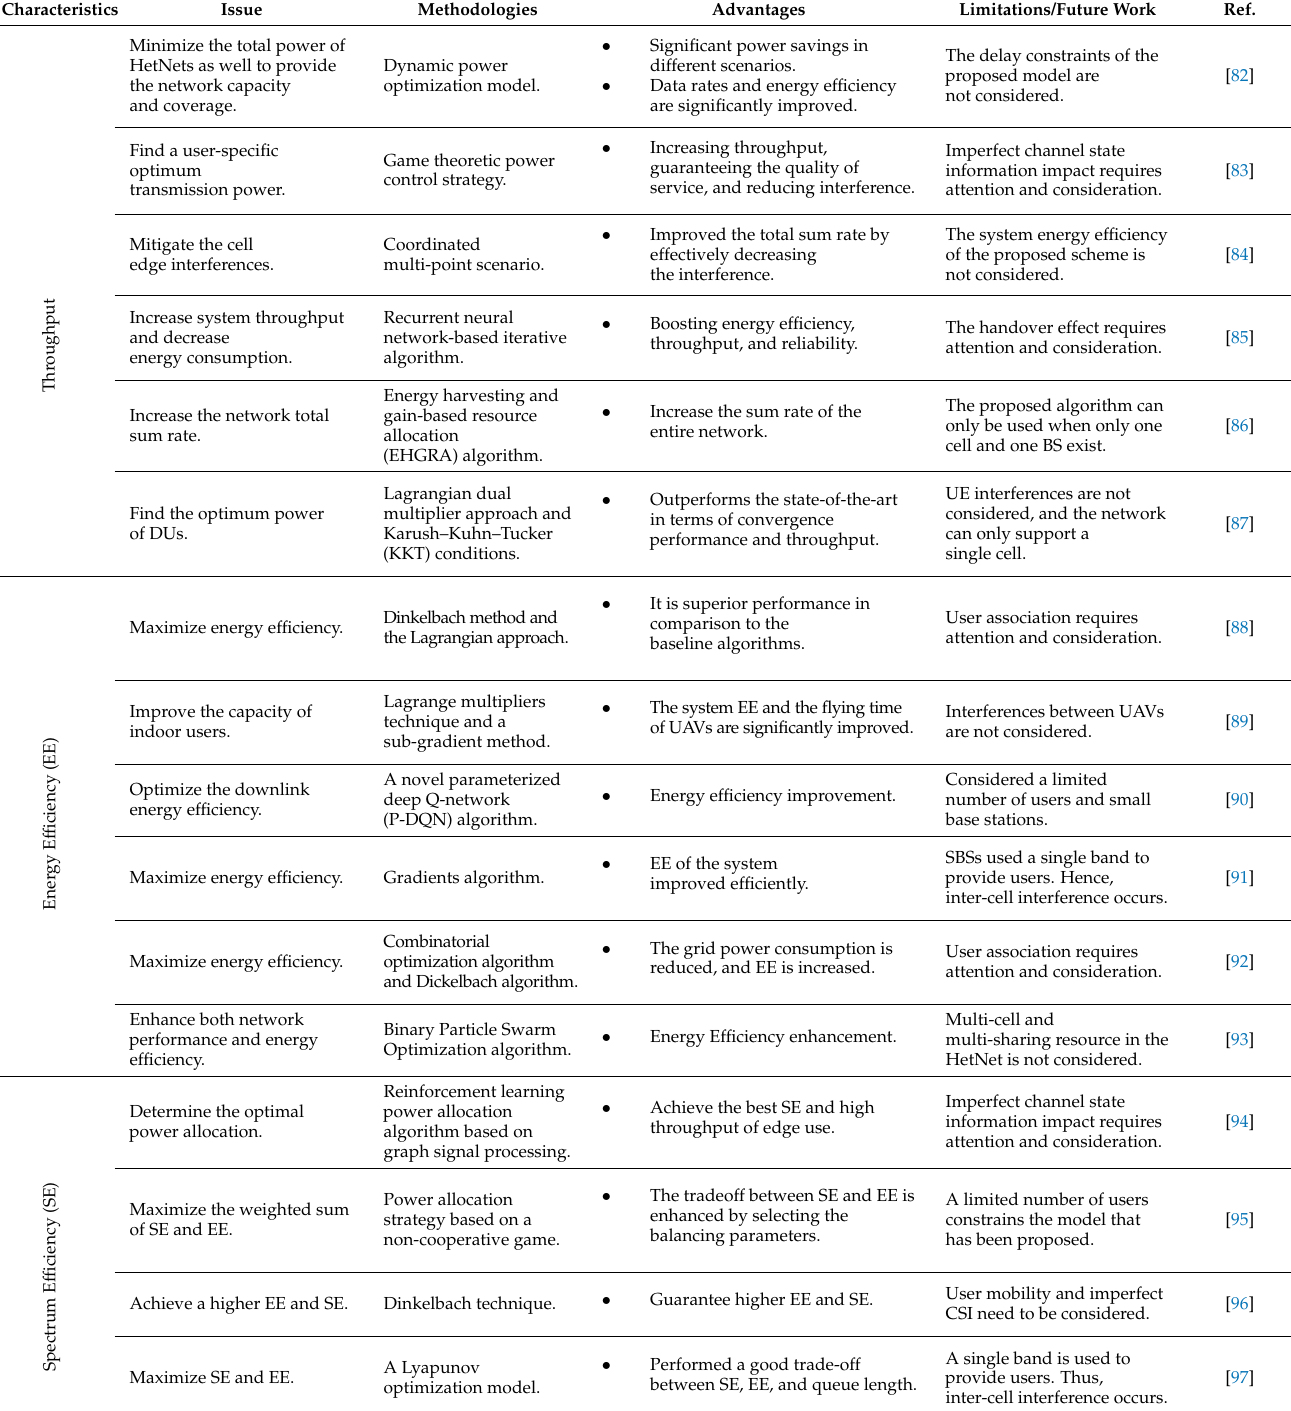
Table 2. Summary of the related work for power